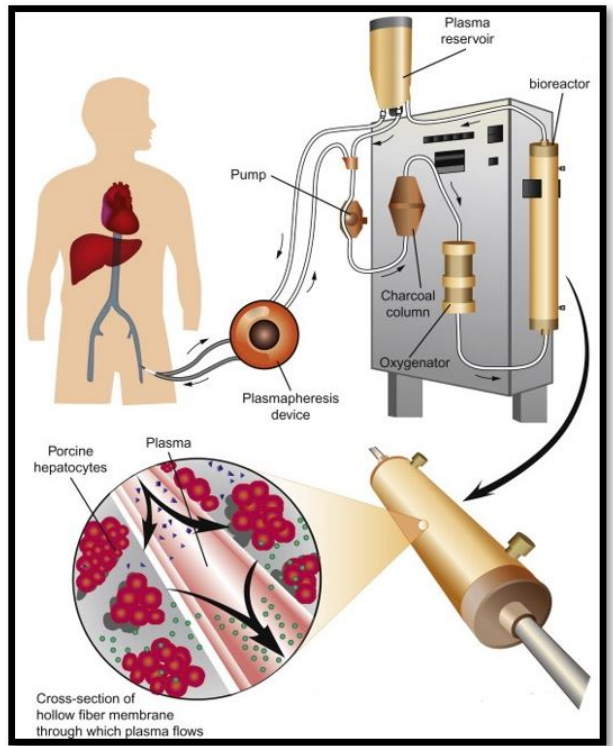
Figure 7. Bioartificial liver support system [91] .